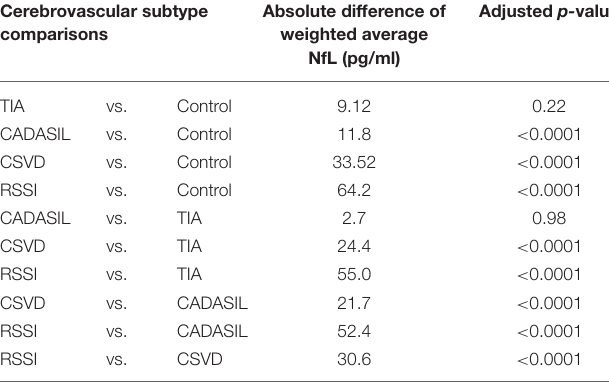
TABLE 2 | Comparative blood NfL levels by cerebrovascular disease subtype. Cerebrovascular subtype